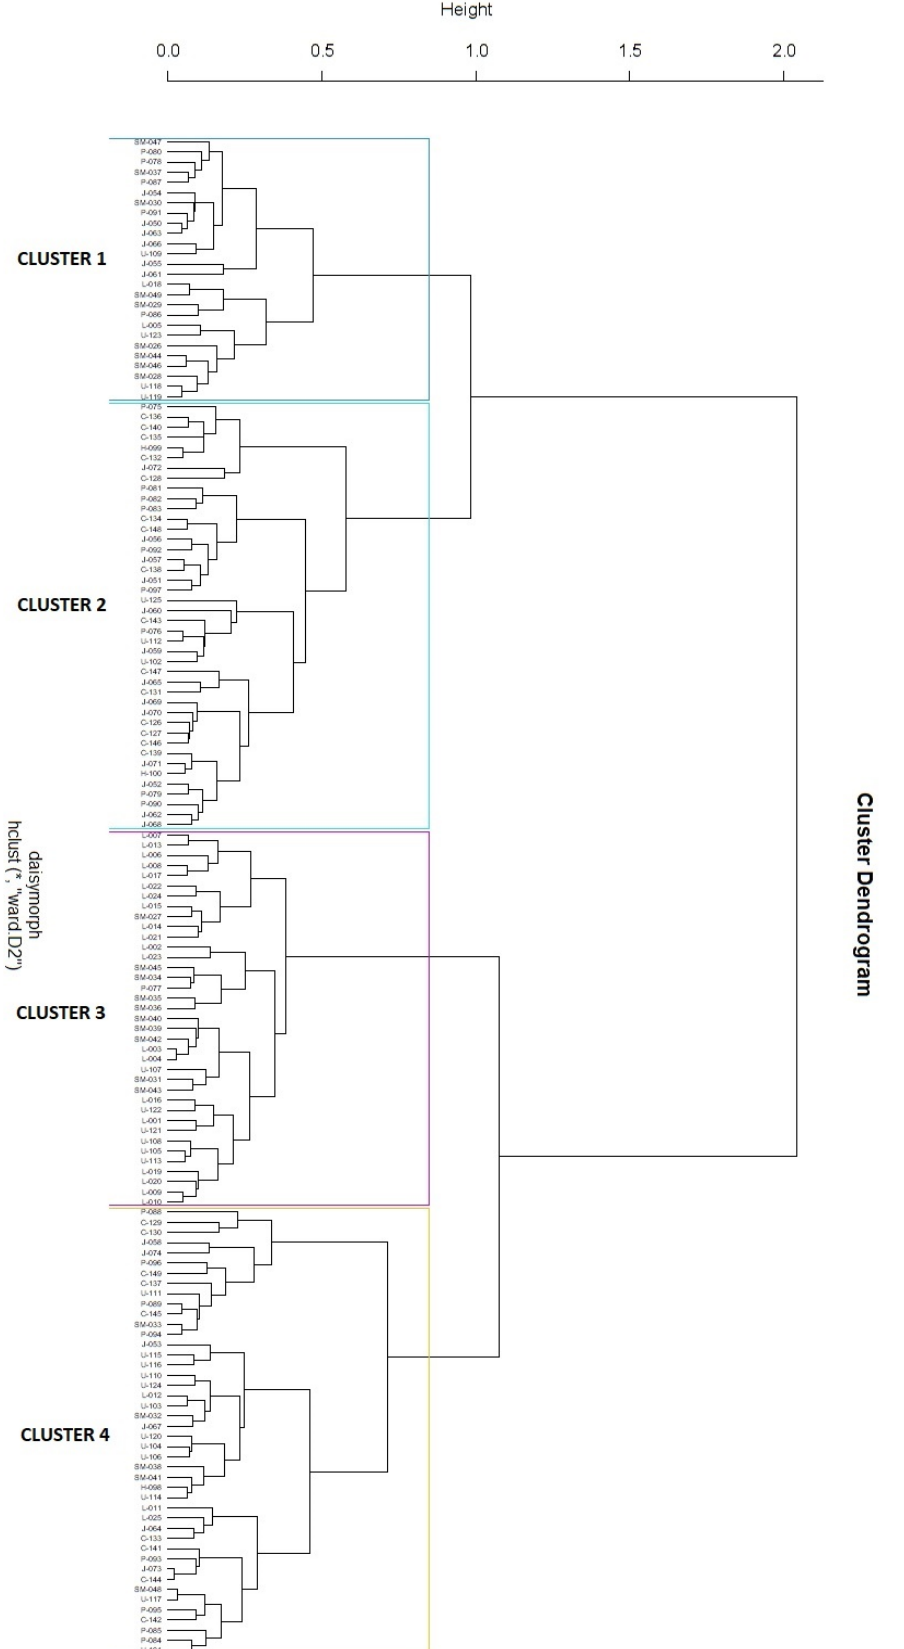
Figure 4. Dendrogram of 149 achiote accessions generated using cluster analysis by processing 13 quantitative and qualitative morphological